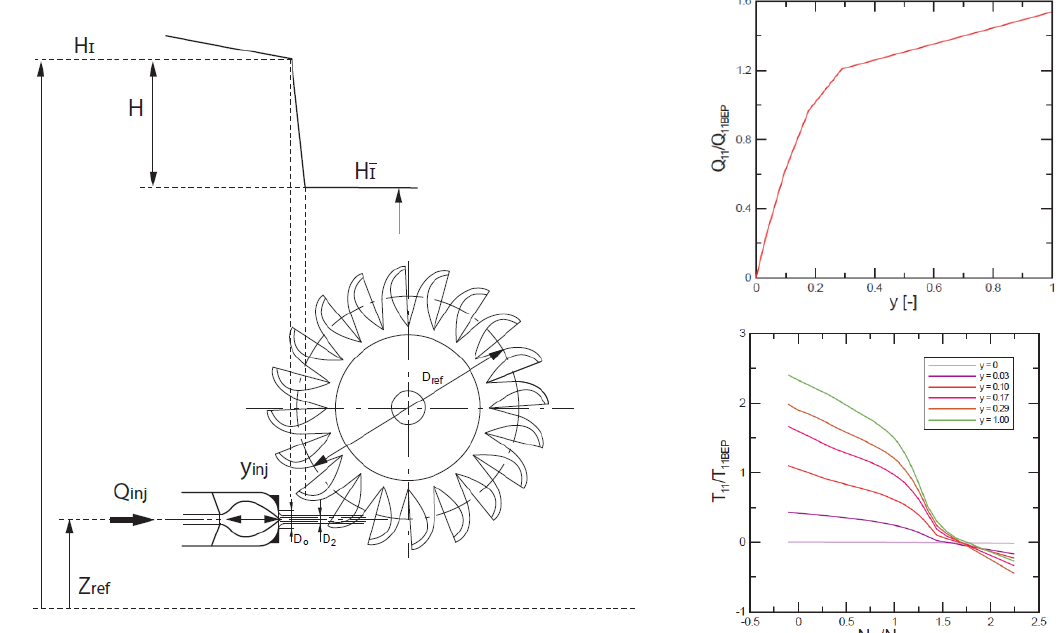
Figure 6. Model of a Pelton turbine ( left ) characteristic curves with injector discharge characteristic curve ( right up ), and torque characteristic curve ( right down ).